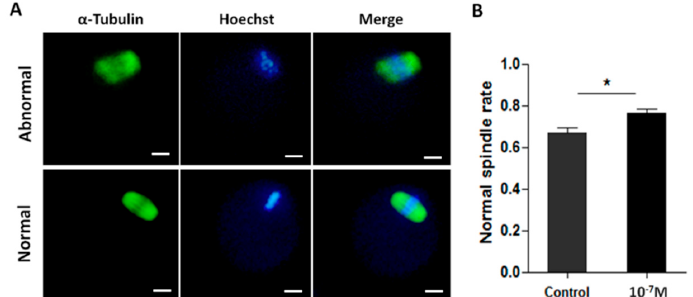
Figure 5. The effects of melatonin on meiotic spindle assembly of MII-stage oocyte. ( A ) Representative images of normal or abnormal meiotic spindle, Scale bar = 20 μ m; ( B ) Incidence of normal spindle in melatonin-treated oocytes compared to the controls (mean ± SEM of 148 oocytes). “*” represent significant differences, p < 0.05.